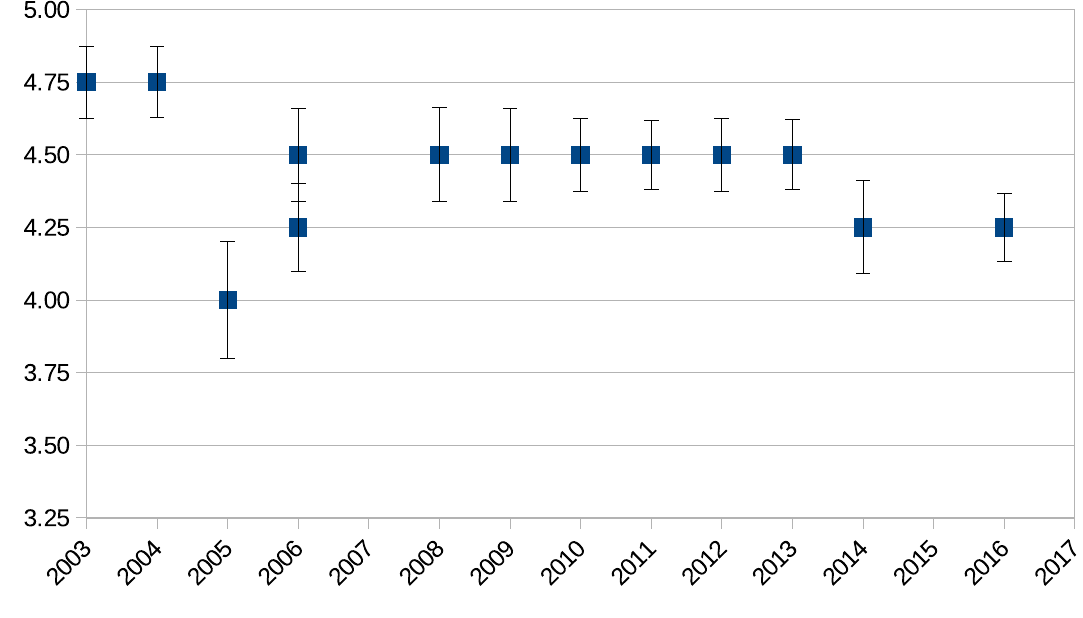
Figure 5. Teaching quality scores and their standard